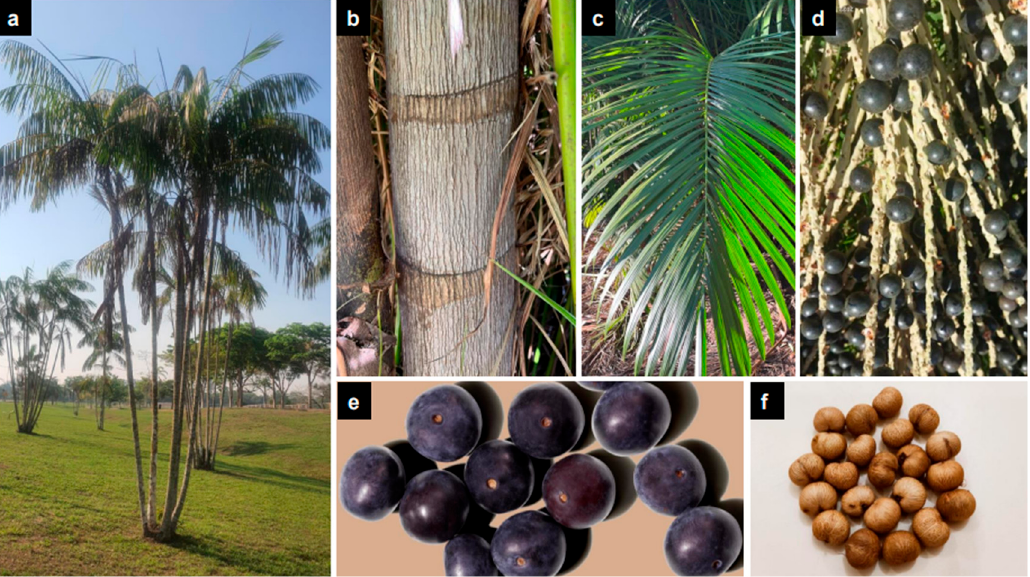
Figure 2. Photographs of various parts of E. oleracea. ( a ) whole plant; ( b ) stem; ( c ) leaf; ( d ) panicles of fruits; ( e ) isolated fruits; and ( f ) isolated seeds.